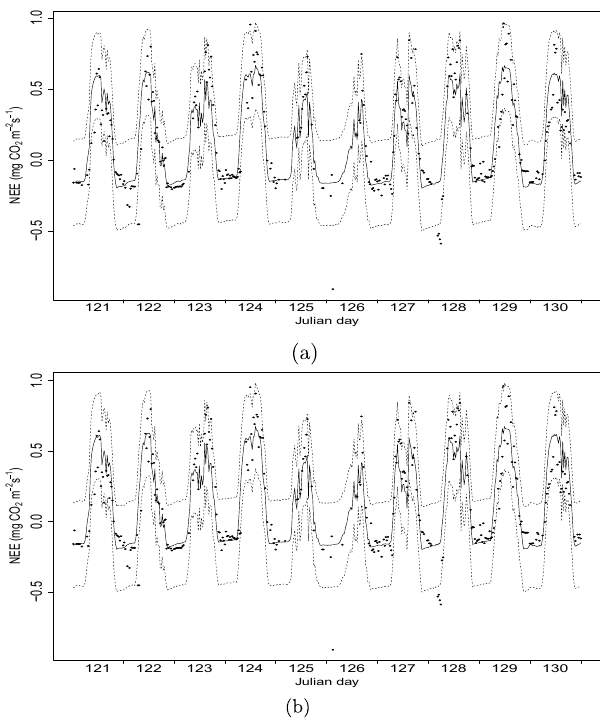
Figure 2. Median (solid lines) and 95% credible intervals (dashed lines) of the posterior distribution of NEE together with half-hourly NEE measurements (solid points) for a 10-day block (1 May to 10 May 2009, Julian days 121 to 130): (a) when using informative prior distributions, (b) when using non-informative prior distributions.